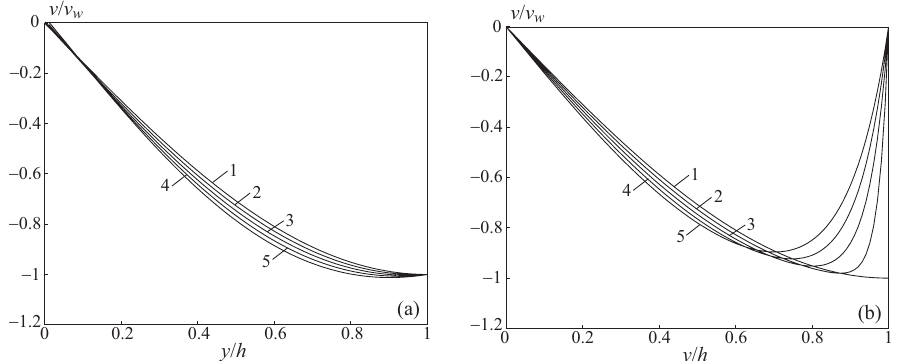
Figure 8. Distributions of axial velocity of particle for Stk = 0.025 (2); 0.05 (3); 0.075 (4); 0.1 (5). Line 1 correspond to fluidflow.